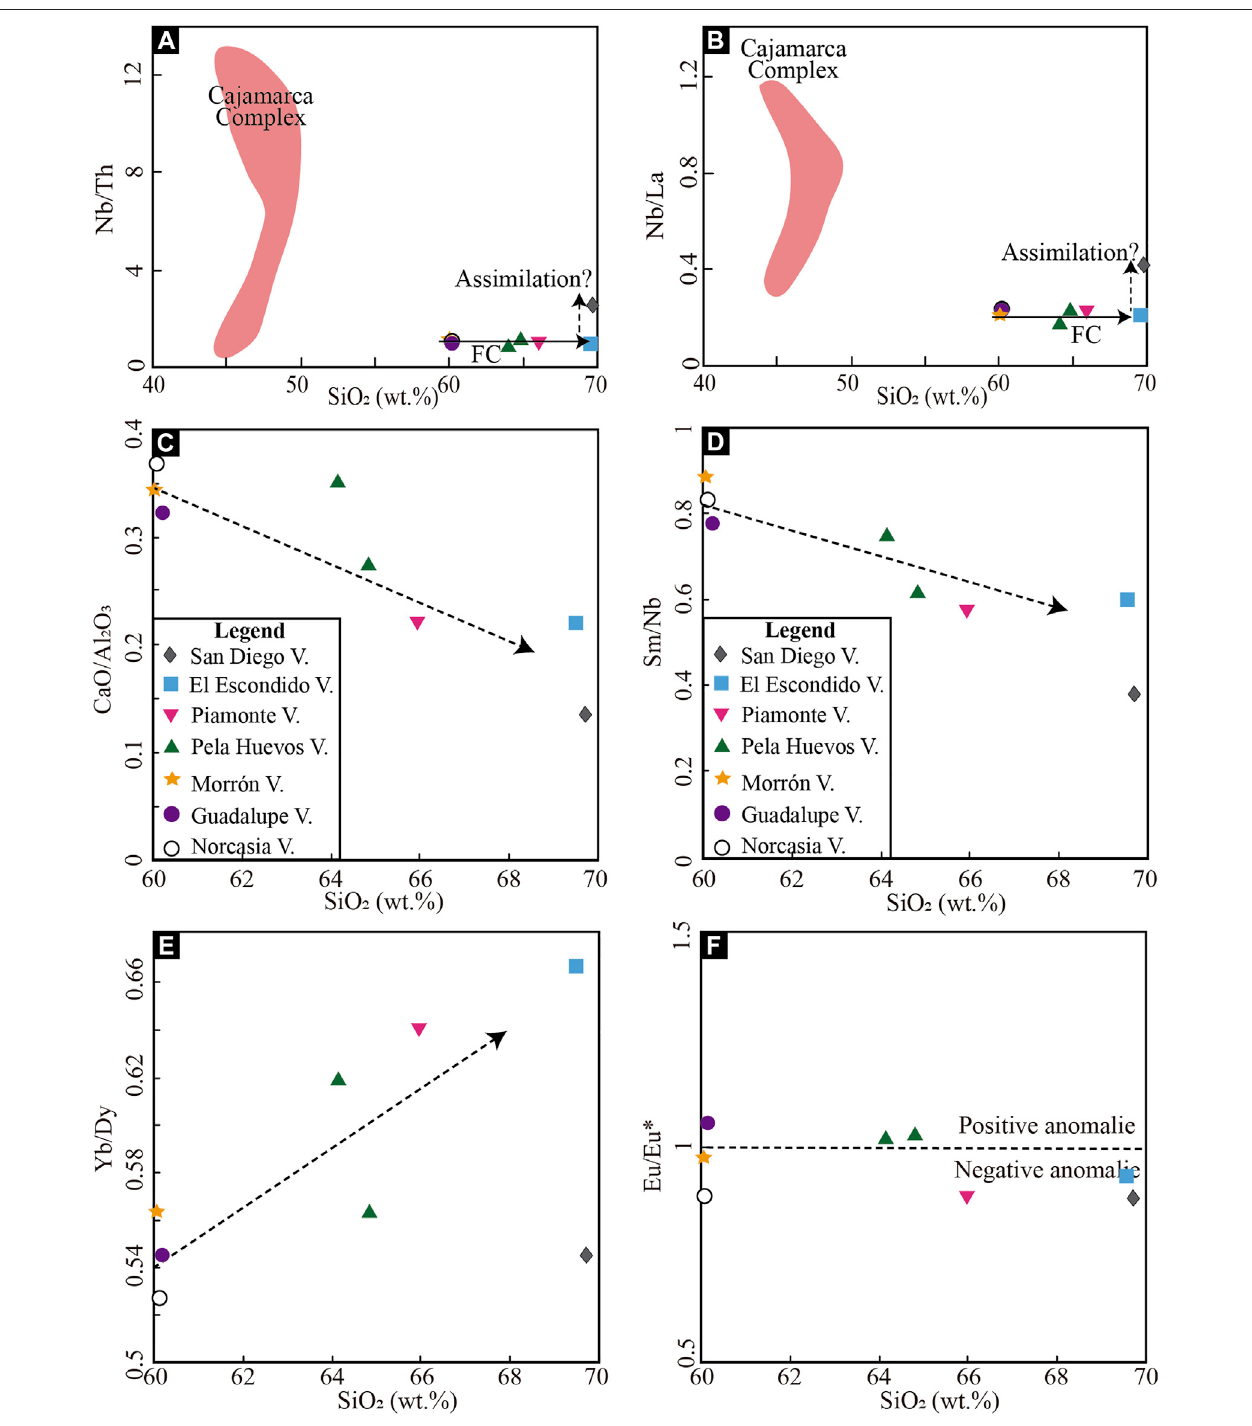
FIGURE 10 | Petrogenetic evolution based on SiO 2 and incompatible trace elements. (A,B) Diagrams of SiO 2 vs. incompatible element ratio of the volcanoes of Samaná monogenetic volcanic fi eld and Cajamarca Complex (Blanco-Quintero et al., 2014). (C) Diagram of SiO 2 vs. CaO/Al 2 O 3 to determine fractionation of Ca-rich minerals (plagioclase and clinopyroxene). The arrow indicates the increase in the degree of fractionation to these phases in different volcanoes. (D,E) Diagrams of SiO 2 vs. compatible element ratio. The arrow indicates the increase in the degree of fractionation. (F) Diagram of SiO 2 vs. Eu/Eu* to determine Eu anomalies. Eu/Eu* = (EuN/ √ (SmN x GdN)), and the values are normalized to the chondrite value of Nakamura (1974). Abbreviations: (FC), fractional crystallization.